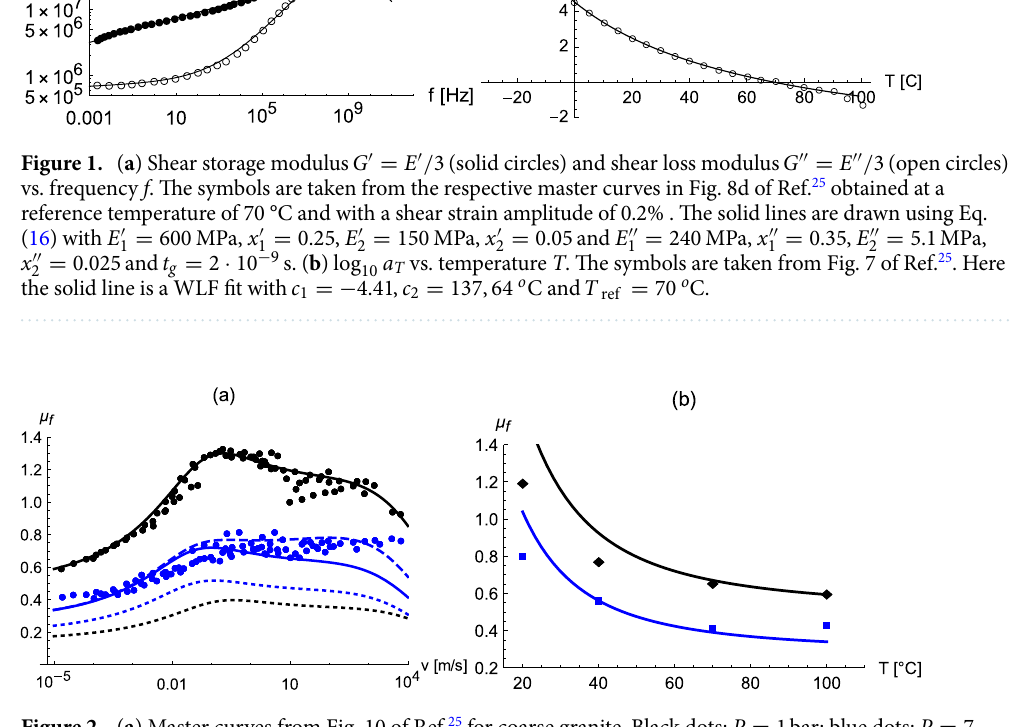
shown in Fig. 7 of Ref. 25 . For the interface tension we assume �γ = 50 mJ/m 2 . Even though this is a guess, similar numbers have been measured for not too different systems 26,27 . Note that (cid:31) 0 ≈ 1.3 · 10 − 6 m and u eq ≈ 17 % when P = 1 bar and (cid:31) 0 ≈ 0.6 · 10 − 6 m and u eq ≈ 33 % when P = 7 bar. Note also that the parameters are adjusted to yield the best fit to the data at P = 1 bar. The theoretical curve for P = 7 bar (solid blue line in Fig. 2a) is obtained with the same parameter values without additional adjustment. The dashed blue curve is obtained with H = 0.868 instead of H = 0.858 . The motivation for including this curve as a comparison is the idea that increasing the pres- sure conceivably affects the interface and thus the value of the scaling exponent. The interplay between pressure and interface tension is demonstrated by the dotted lines in Fig. 2a, corresponding to the solid lines of the same colour when �γ = 25 mJ/m 2 instead of 50 mJ/m 2 . Note that the significant reduction of �γ not only reduces µ